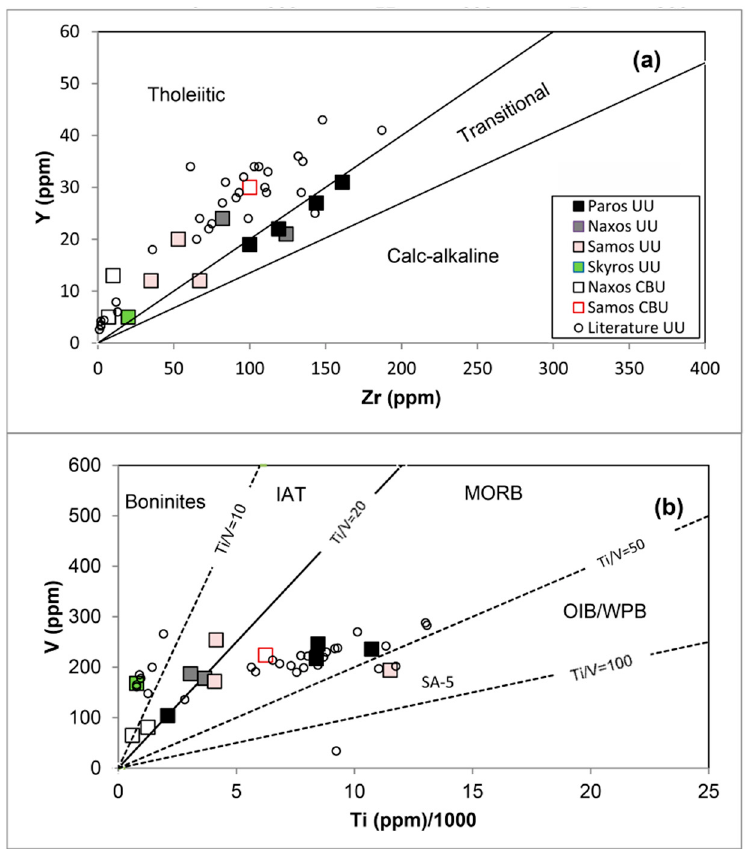
Figure 6. ( a ) Zr vs. Y and ( b ) Ti vs. V [56] tectonic-magmatic discrimination of Cycladic ophiolitic metabasites.